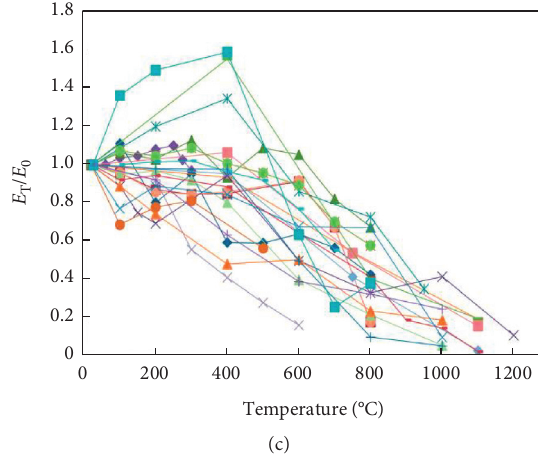
c [46]; (b) tensile strength σ t [47]; (c) elastic